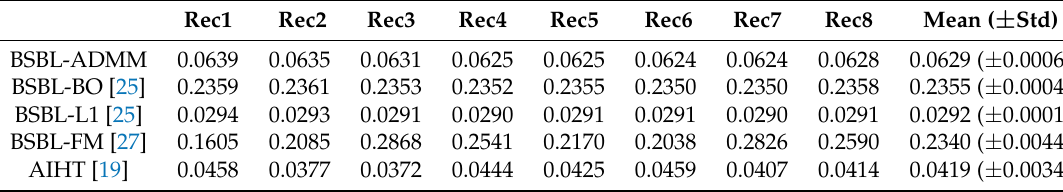
Table 2. The details of recovery CPU Time of practical wearable ECG datasets (CR = 60%). These results show that the proposed BSBL-ADMM algorithm is robust for the recovery speed for different ECG recordings. Rec1 Rec2 Rec3